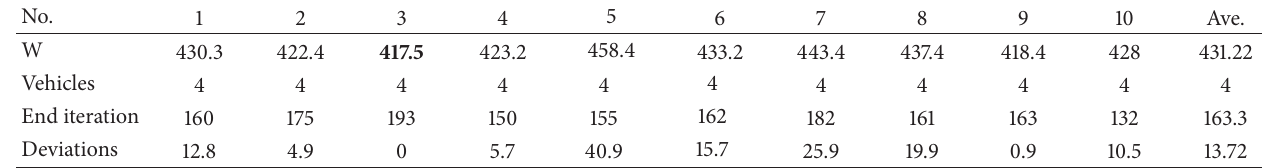
Table 9: The results of basic ant colony algorithm (moderate or high level pollution).